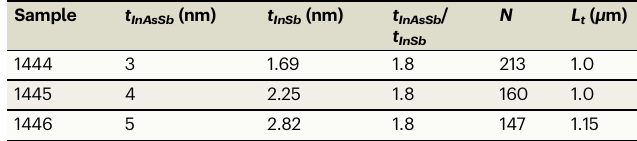
Table 1 | Sample structure